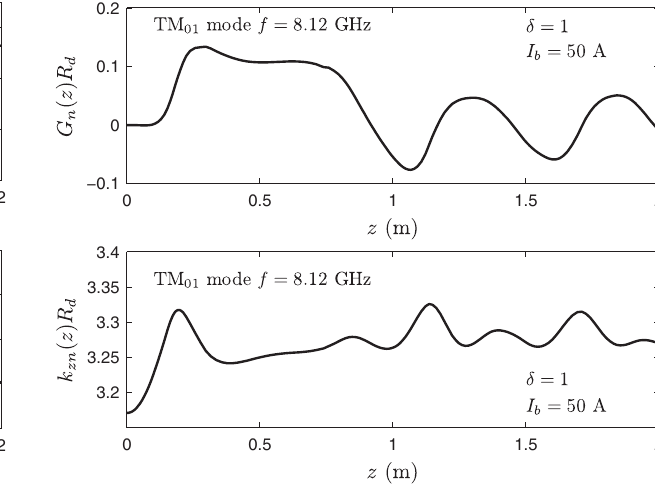
FIG. 6. TM 01 power at 8.12 GHz and beam energy loss.